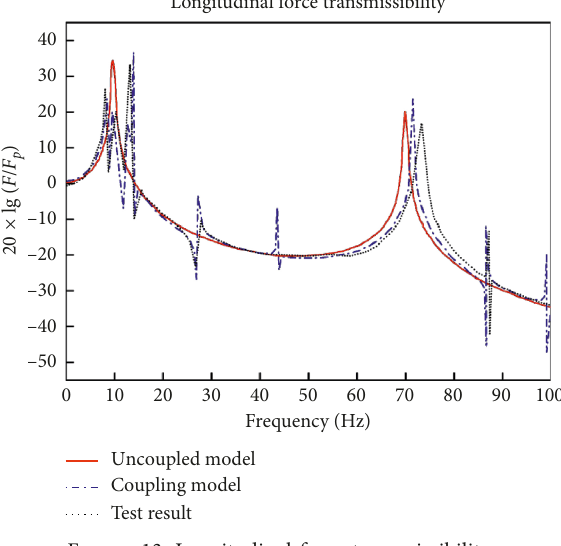
Figure 13: Longitudinal force transmissibility.